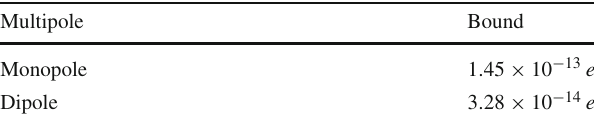
Table 2 Bounds of the charge of the bosons required to the rotation curves to lay inside the 1 σ confidence region of F563 data